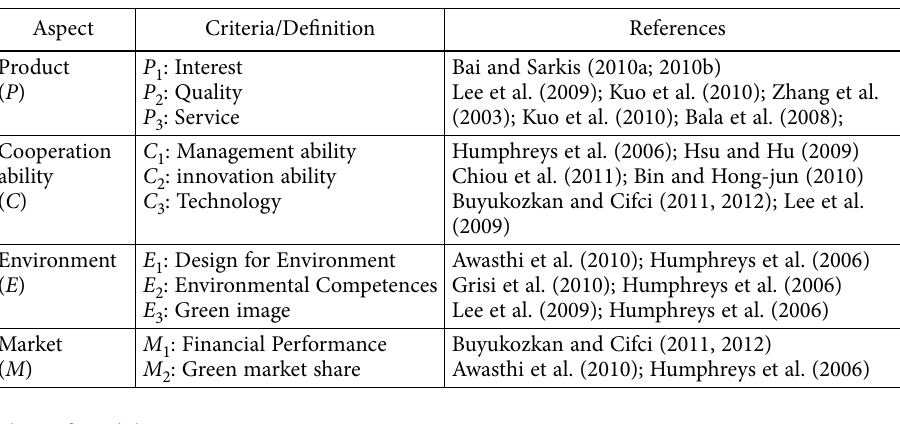
Table 2. Evaluation index system of green supplier selection